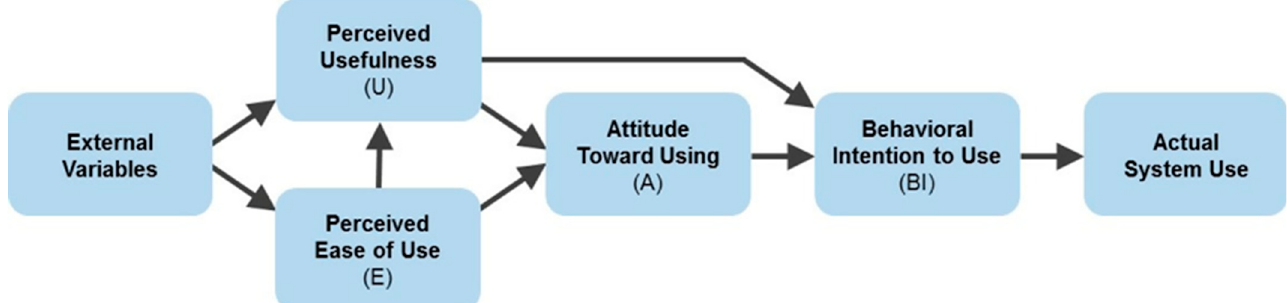
Figure 1. Technology acceptance model.